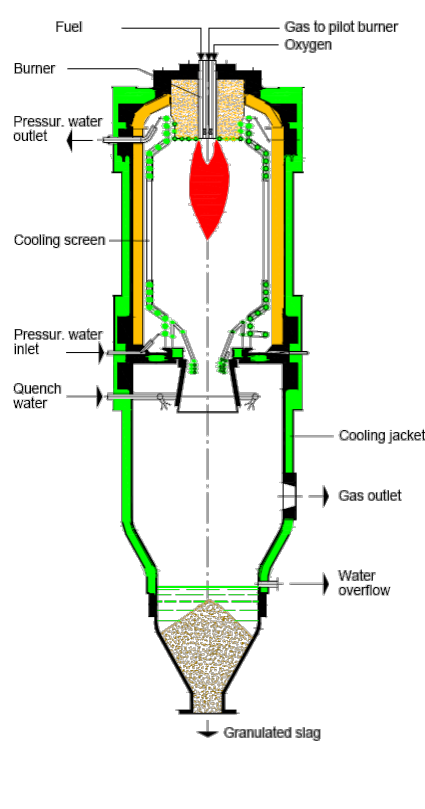
Figure 9. Siemans Gasifier